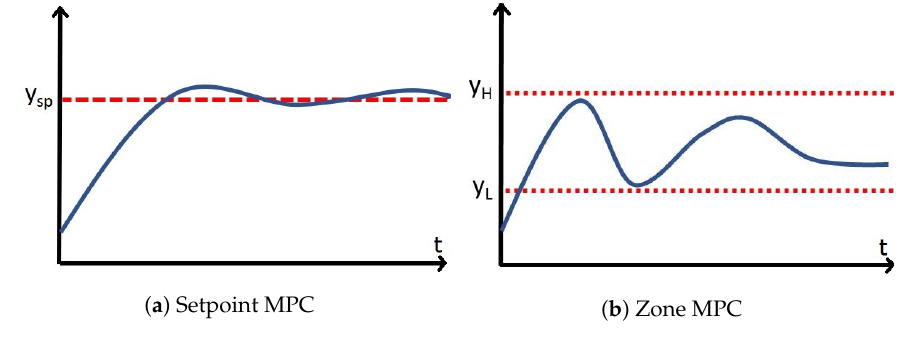
Figure 3. Comparison of setpoint and zone tracking